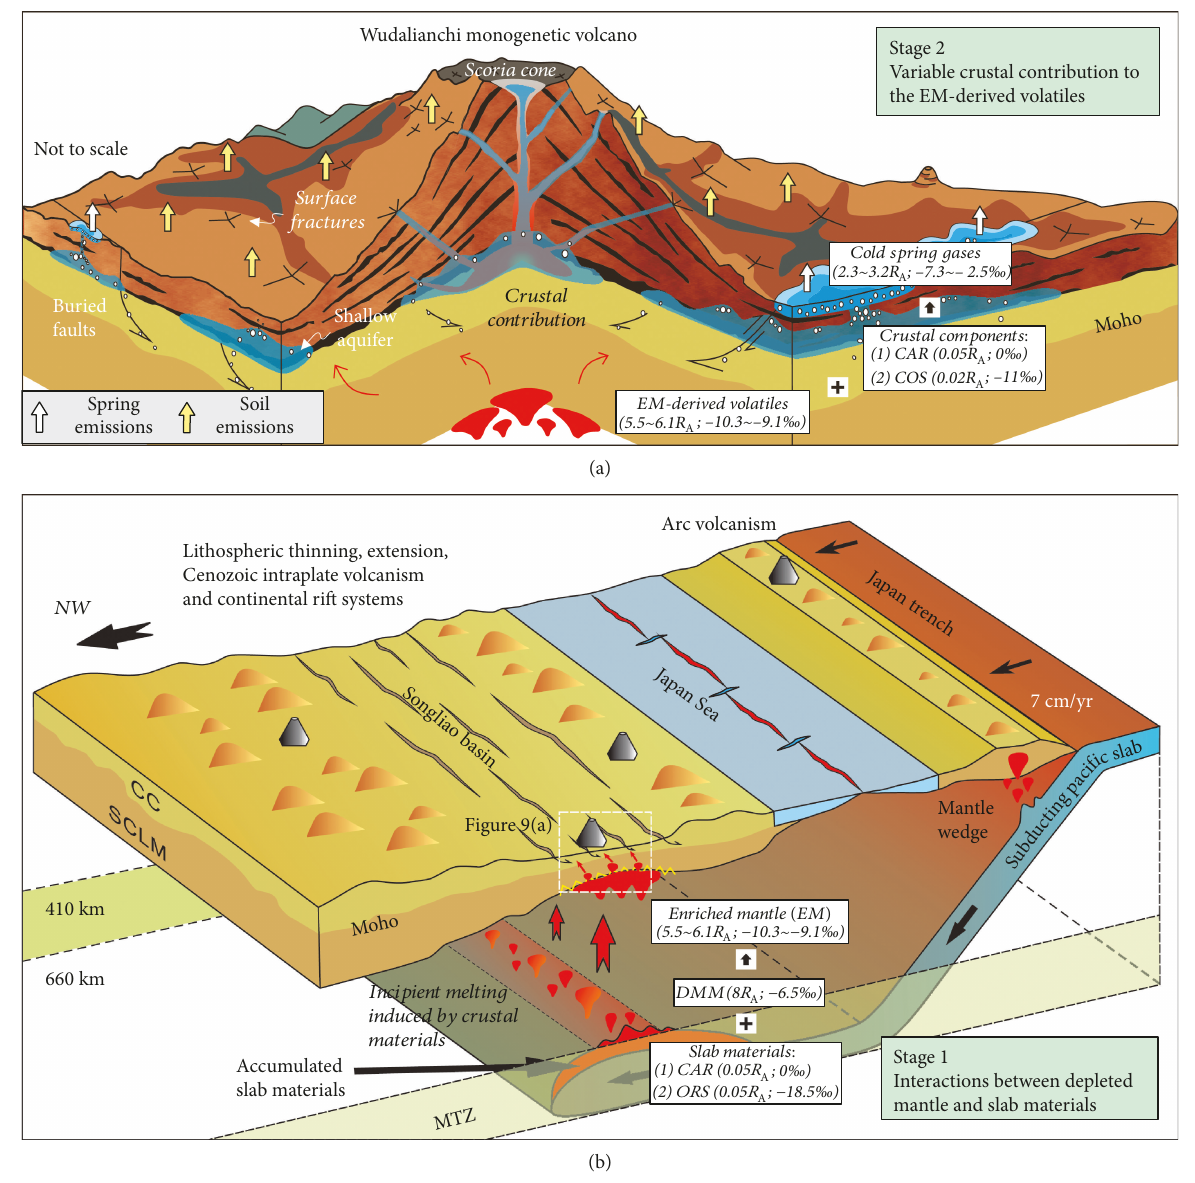
Figure 9: Genetic model of the cold spring gases in WMVF. (a) Crustal contribution to the EM-derived volatiles. (b) A schematic map shows the interactions between the depleted mantle and the slab materials in the MTZ. Abbreviations are as follows: MTZ: mantle transition zone; Moho: Mohorovi č i ć discontinuity; SCLM: subcontinental lithospheric mantle; CC: continental